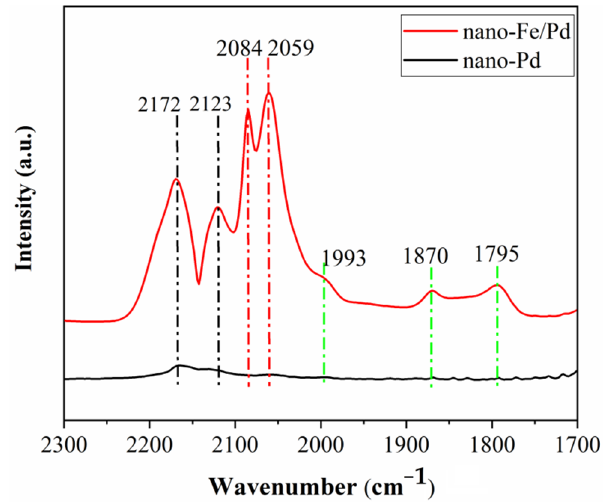
Figure 12. IR spectra of CO adsorbed on nanocatalyst.